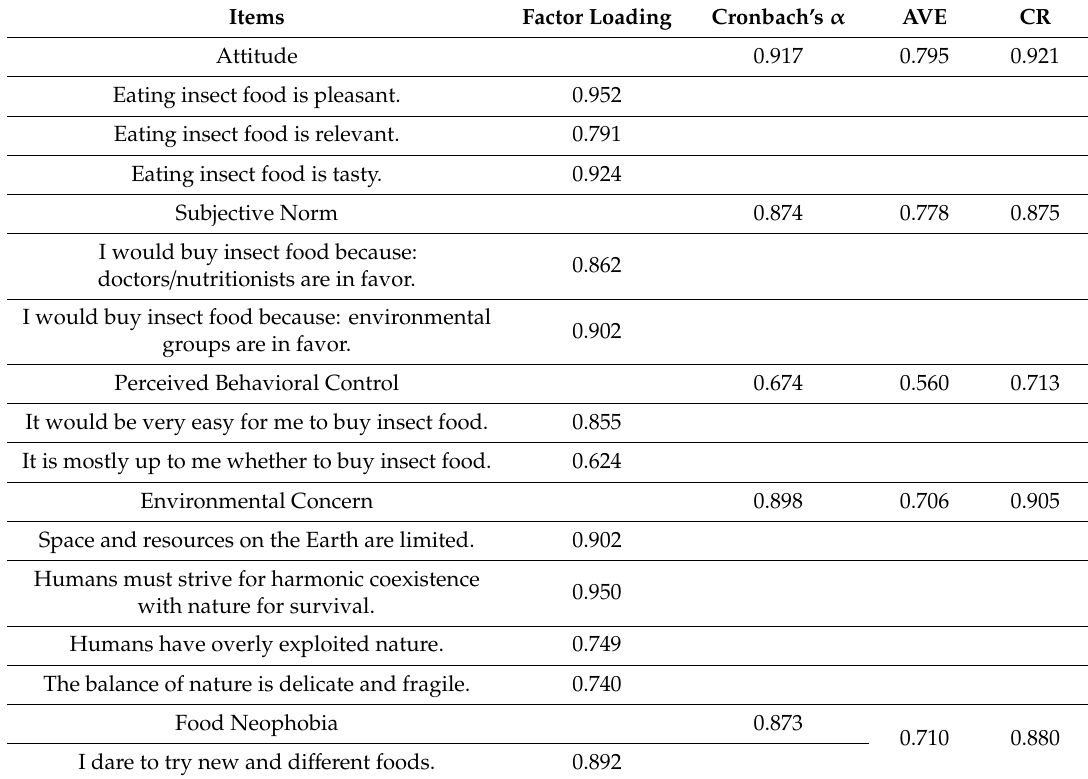
Table 1. Results of factor loading, reliability, and